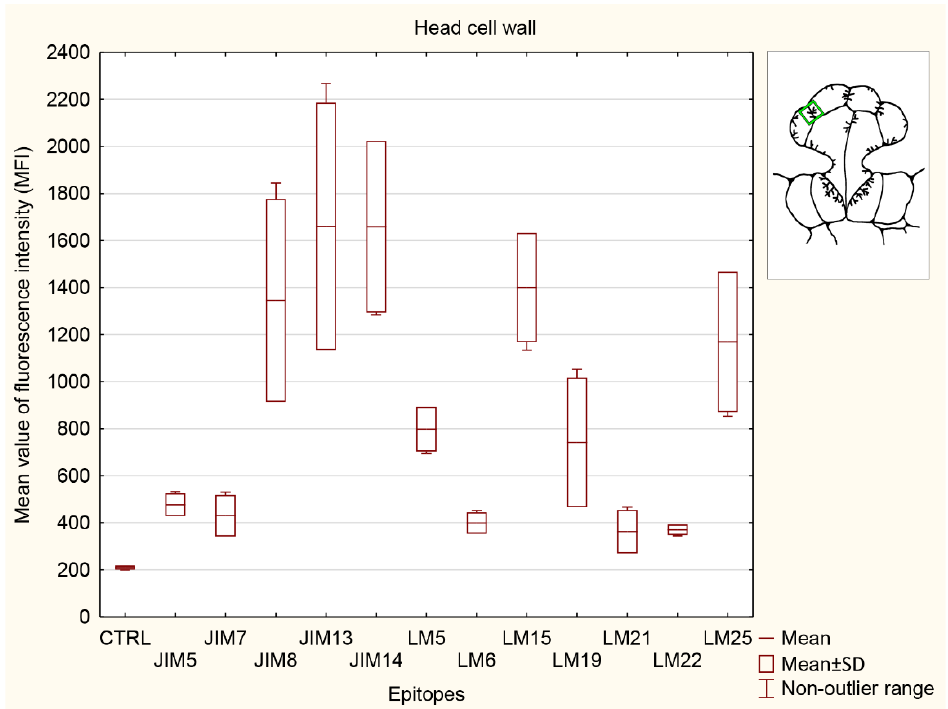
Figure 7. Quantification of immunofluorescence labeling for the head cell wall. Mean values of AGP fluorescence intensity (MFI) for negative control reaction (CTRL) and for labeled AGPs (JIM14, JIM8, and JIM13 epitopes), pectins (JIM5, JIM7, LM5, LM6, and LM19 epitopes), hemicelluloses (LM 15 and LM25 epitopes), and heteromannans (LM21 and LM22 epitopes) in 3 glands from 3 different traps (n = 3).